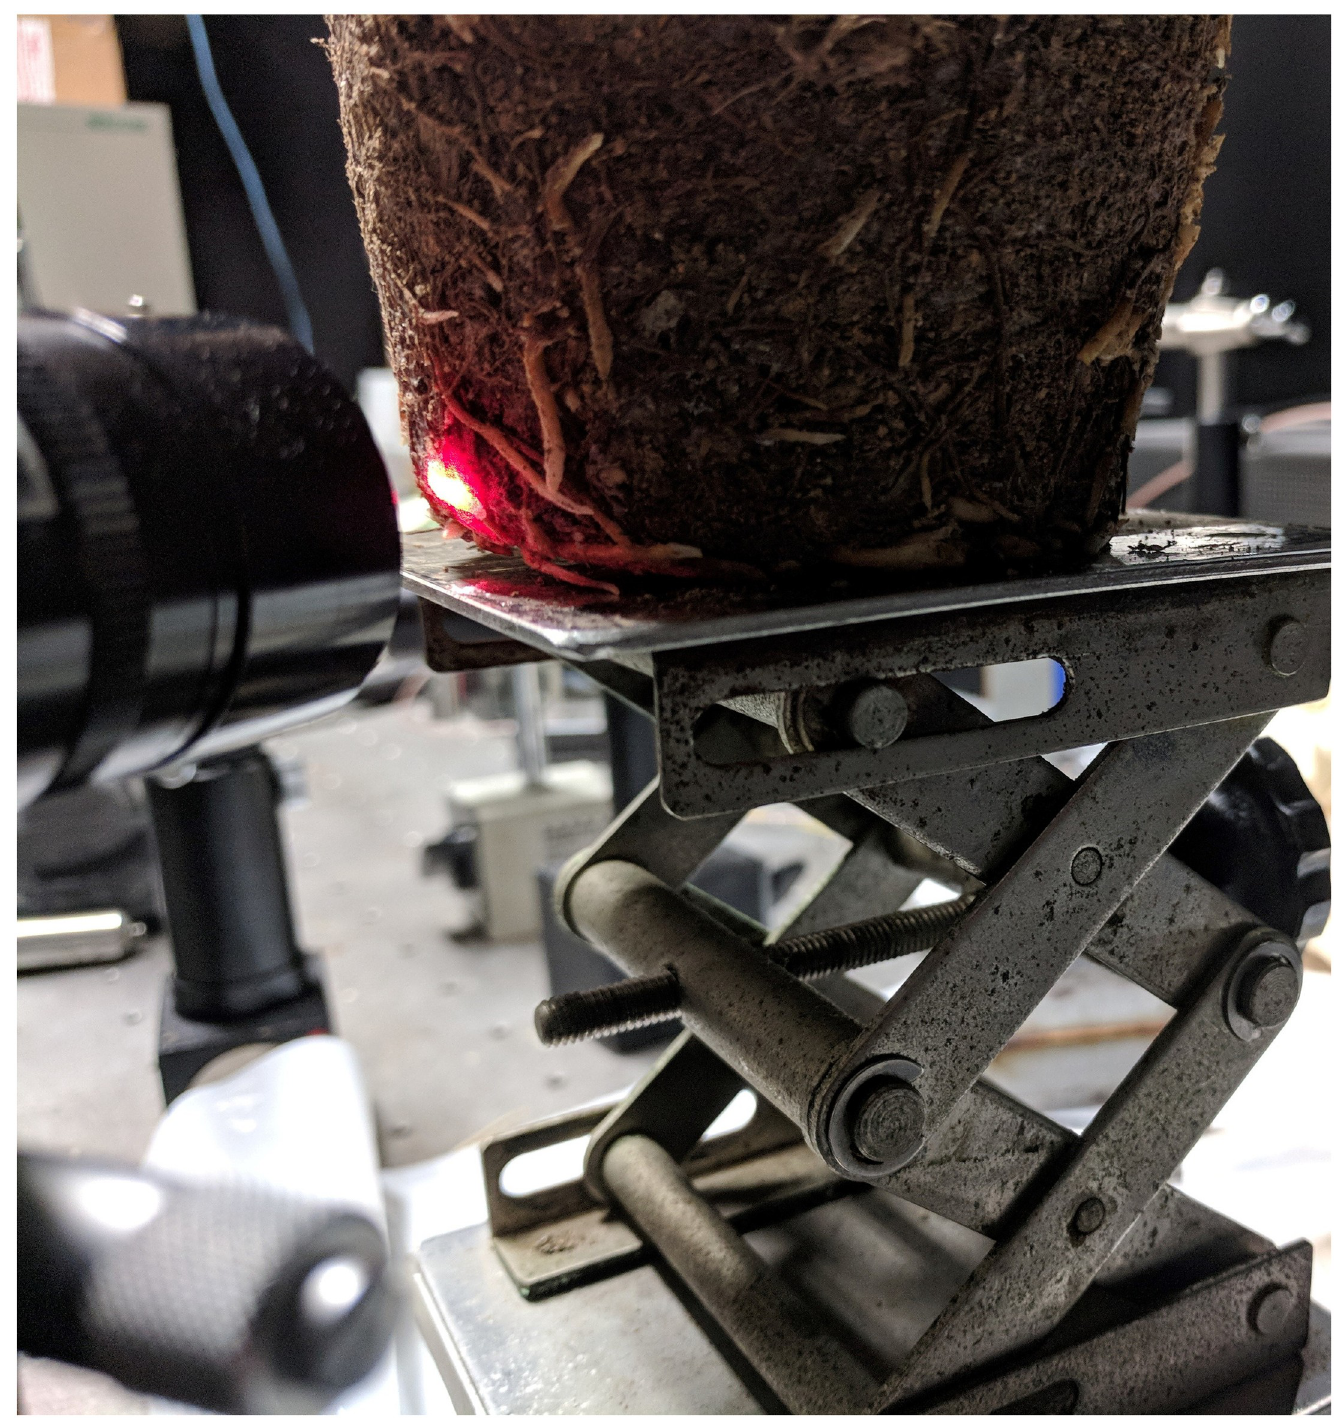
Fig 4. Two illuminating points are cast on the tip of a root.